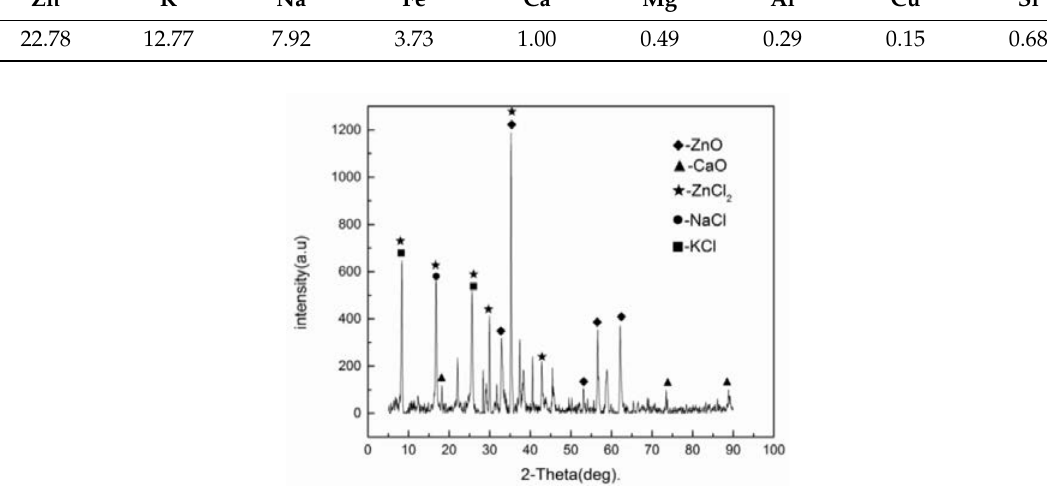
Figure 4. X-ray di ff raction pattern of RHF secondary dust. Figure 4. X- ray diffraction pattern of RHF secondary dust. Table 6. Chemical analysis results of RHF secondary Table 6. Chemical analysis results of RHF secondary dust.